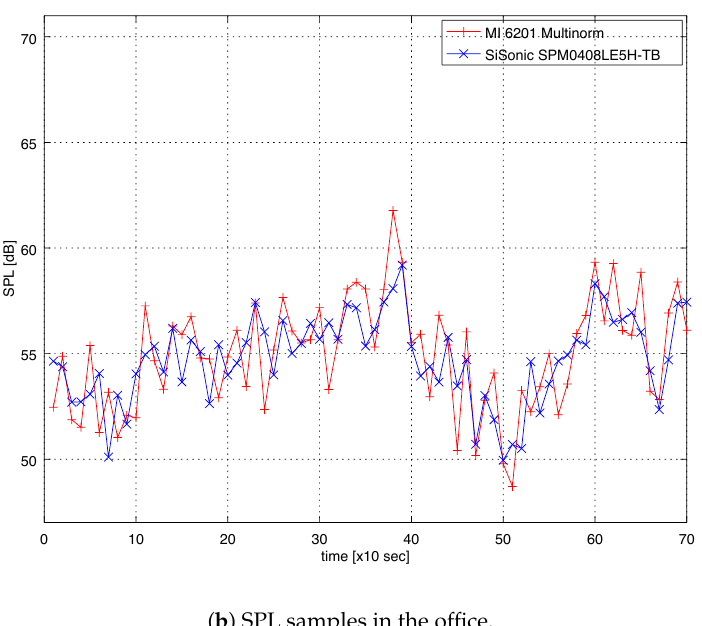
Figure 12. ( a ) SPL samples of recordings in the department hall during a break between lectures. At the time 400 s lectures resume and SPL drops; ( b ) SPL samples of recordings in the office with six people. Both recordings lasted 12 min, the samples are taken in 10 s